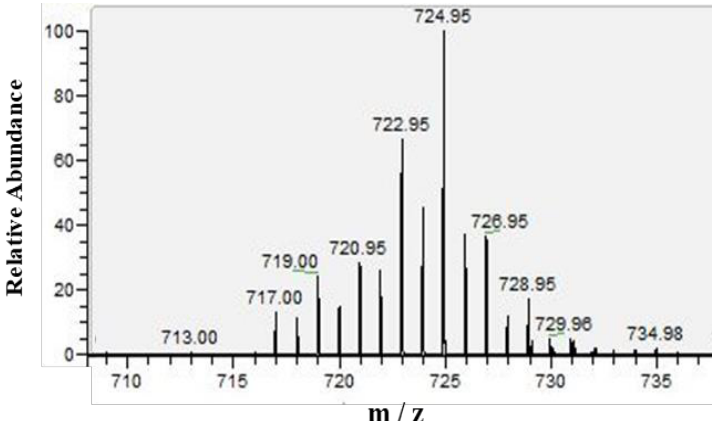
Figure 3. Mass spectra of solutions of 100 μM HKaem with 50 μM SnCl 2 in methanol. Table 1. Mass spectra ( m/z ) of 100 μM Kaem with 50 μM SnCl 2 in methanol.